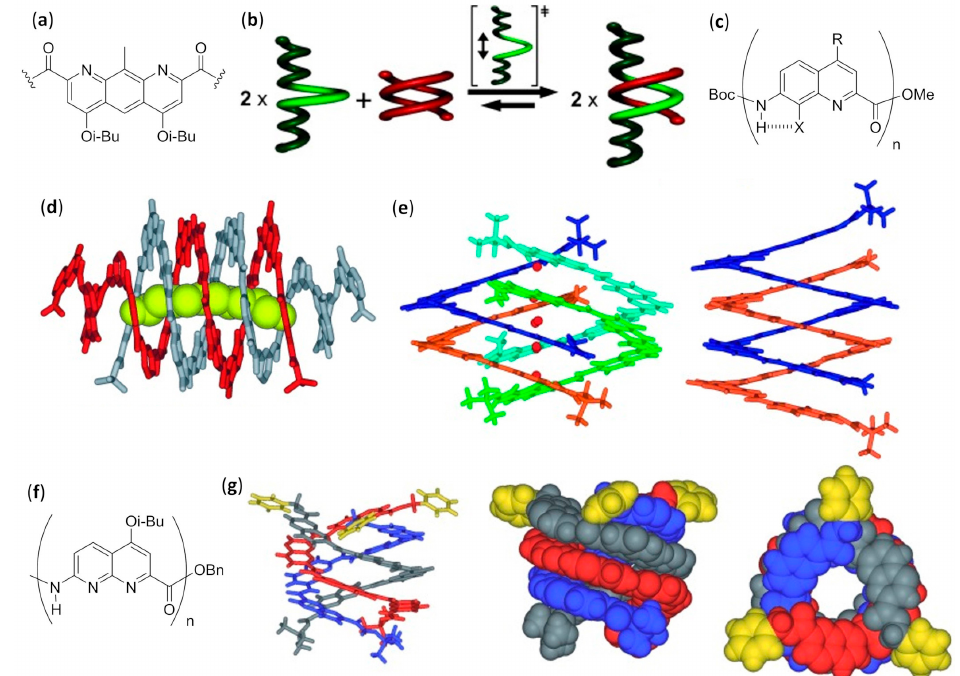
Figure 11. ( a ) Structure of 1,8-diazaanthracene-2,7-dicarboxylic acid unit (Refs. [19,150–152]); ( b ) Formation of a heterodimer by disassembly of a short double helix with a wide diameter (red) and cross-hybridization with a longer single helix with variable diameter (green) (adapted with permission from Ref. [151]); ( c ) General structure of 7-amino-8-fluoro- or 8-chloro-2-quinolinecarboxylic acid strands (Refs. [154,158–160]); ( d ) Crystal structure of the variable diameter single/double helical capsule containing 1,10-decanediol (strands and guest reported in different colors) (reprinted with permission from Ref. [153]); ( e ) Crystal structures of (left) quadruple helix of tetrameric 7-amino-8-fluoro-2-quinolinecarboxylic acid (X = F, n = 4 in panel c), with some water molecules reported as spheres, and (right) double helix of the octamer (X = F, n = 8 in panel c) with alkoxy residues and solvent molecules omitted for clarity (different strands reported in different colors; adapted with permission from Ref. [154]); ( f ) Structure of 2-amino-5-isobutoxy-1,8-naphthyridine-7-carboxylic acid units (Refs. [30,156,157]); ( g ) Different views and representations of crystal structure of parallel triple helix of Boc-(2-amino-5-isobutoxy-1,8-naphthyridine-7-carboxylic acid) 4 -OBn, with color-coded strands and Ph terminal groups in yellow (reprinted with permission from Ref. [156]). A related heteroundecamer host with two additional quinoline units, Piv-PDCA 3 -(7-amino-8- fluoro-2-quinolinecarboxylic acid) 8 -Boc, was also used with rationally designed rod-like guests with